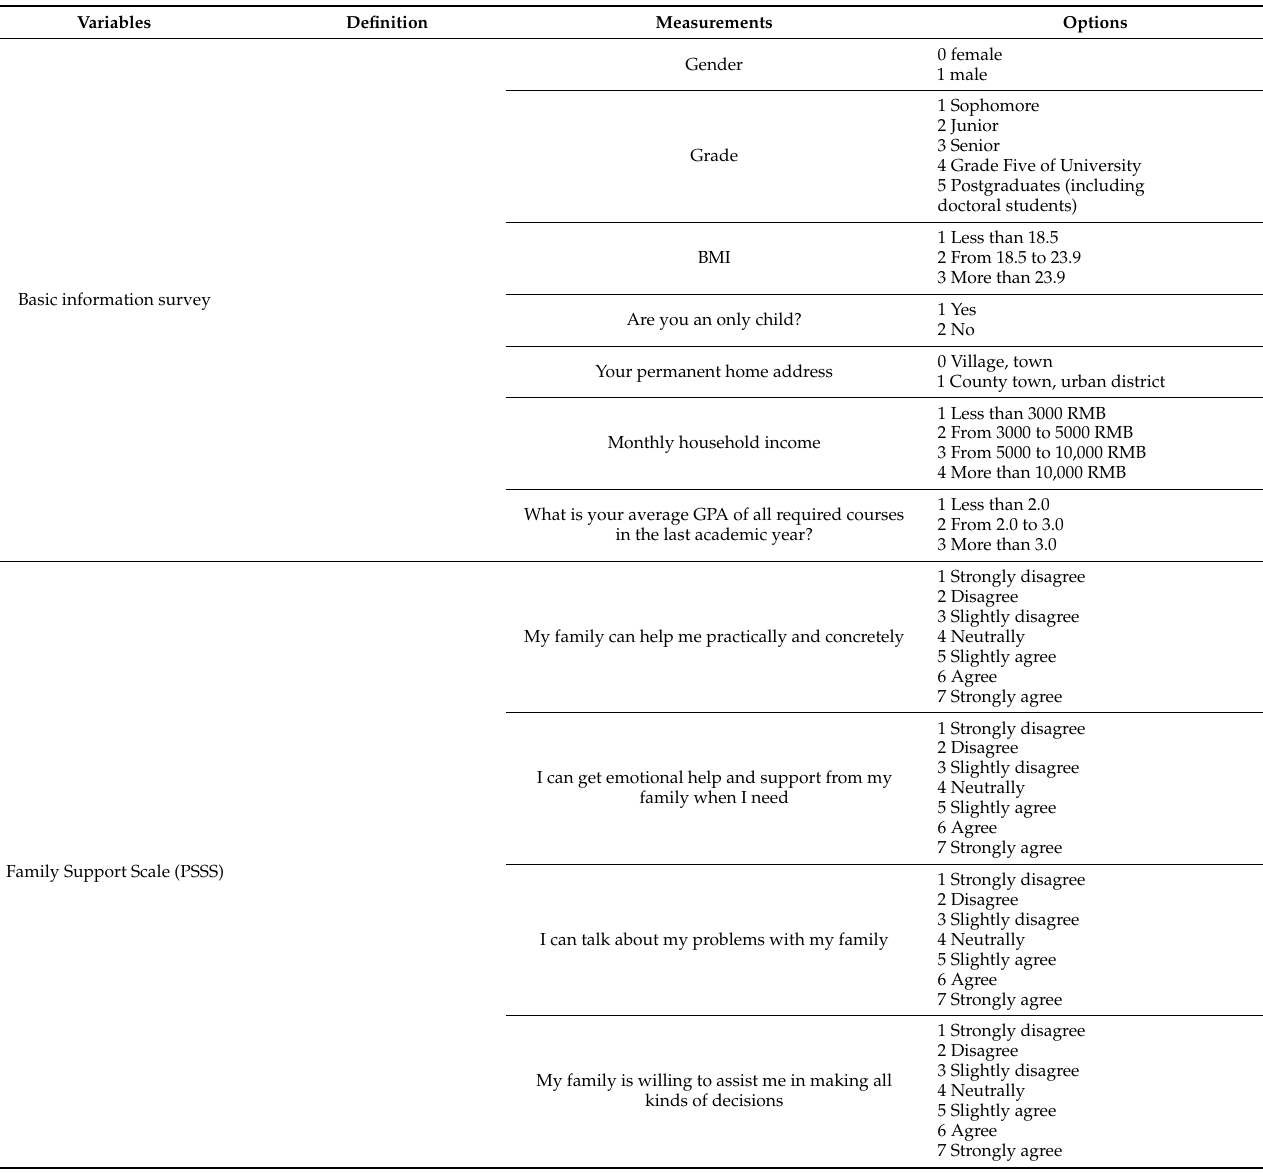
Table A1. Measurements of the variables in this